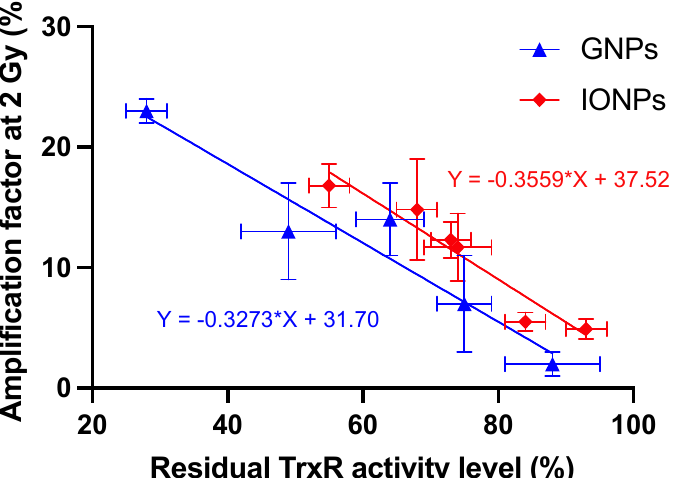
Figure 5. TrxR activity rates calculated from the slope of corresponding TrxR activity curves ex- tracted from the measurement of absorption at 412 nm during 10 min for A549 cells treated with ([Fe] = 50 μg.mL –1 ) and without 7 nm carboxylated IONPs and 7 nm IONPs PEG 5000 for 6 h of incu- bation ( A , D ), 24 h of incubation ( B , E ) and 48 h of incubation ( C , F ). Data are plotted as means ± SD from three independent experiments. One-way ANOVA analysis was performed for each result (Tukey test, *** p < 0.001, ns = not significant). Similar to the irradiation results, no correlation between the amount of internalized iron and the TrxR residual activity could be highlighted for both formulations (r = 0.6446